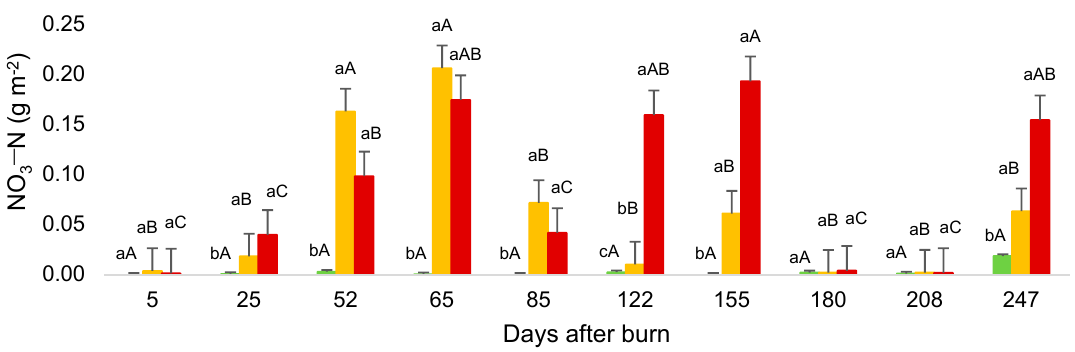
Figure 8. Treatment effect under control (C), moderate severity (MS), and high severity (HS) burn on NO 3— N loss between 5 and 247 days after pile burning. Mean values followed by the different lowercase letters show statistically significant differences within the same date. Mean values followed by the different uppercase letters are statistically significant differences within the same treatment. Significant differences were observed at p < 0.05 . Hanging bars represent the standard error. ( n = 5). TN loss was significantly di ff erent among treatment (F = 12.1, p < 0.0001), sampling dates (F = 2.92, p < 0.05), and treatments × sampling dates interaction (F = 2.1, p < 0.05). In C and HS treatments, no significant di ff erences among sampling dates were observed. At 25, 52, 85,